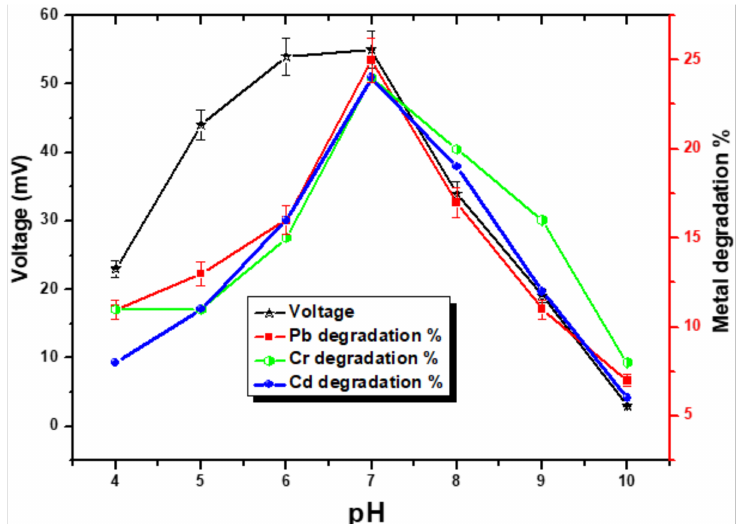
Figure 9. The pH optimization outcomes of the present